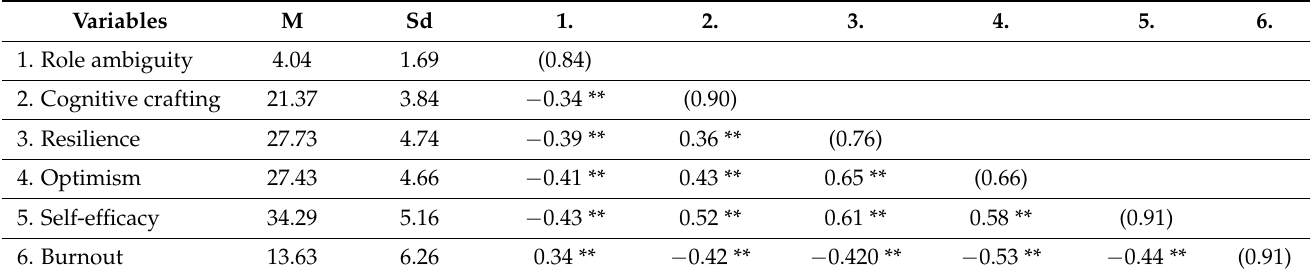
Table 2. Means, standard deviations and correlation coefficients between variables (N =